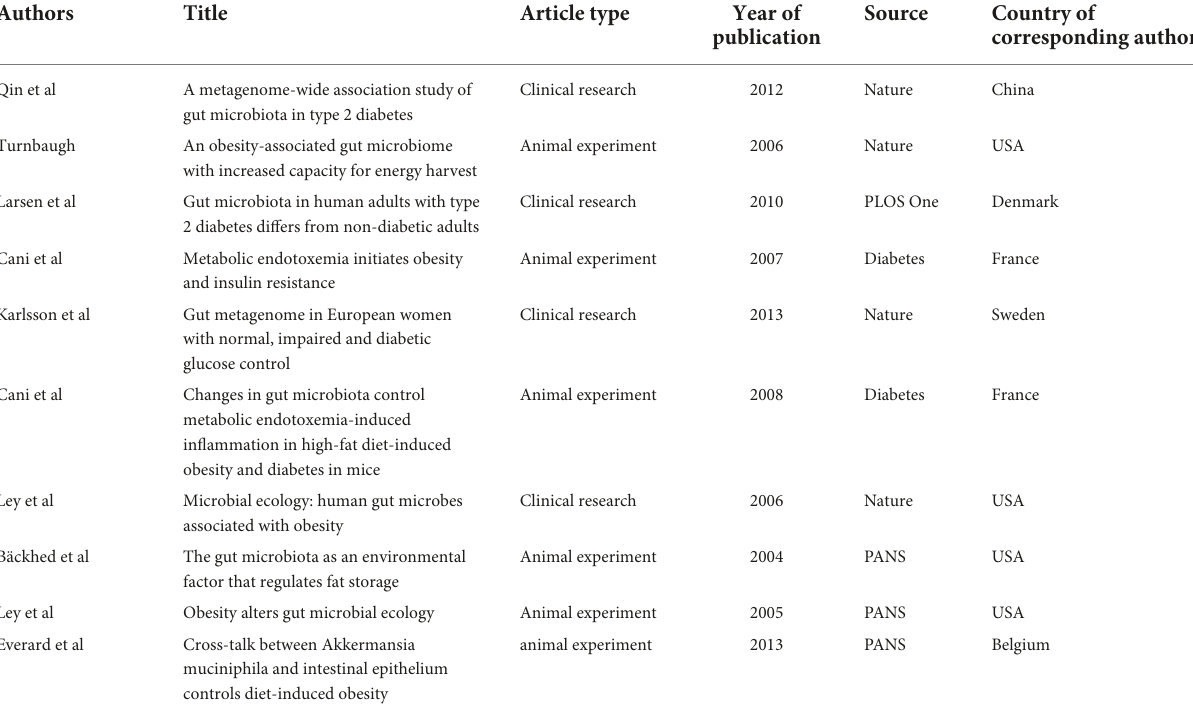
TABLE 6 Top 10 co-cited references in the “gut microbiota and gut microbiota and diabetes”